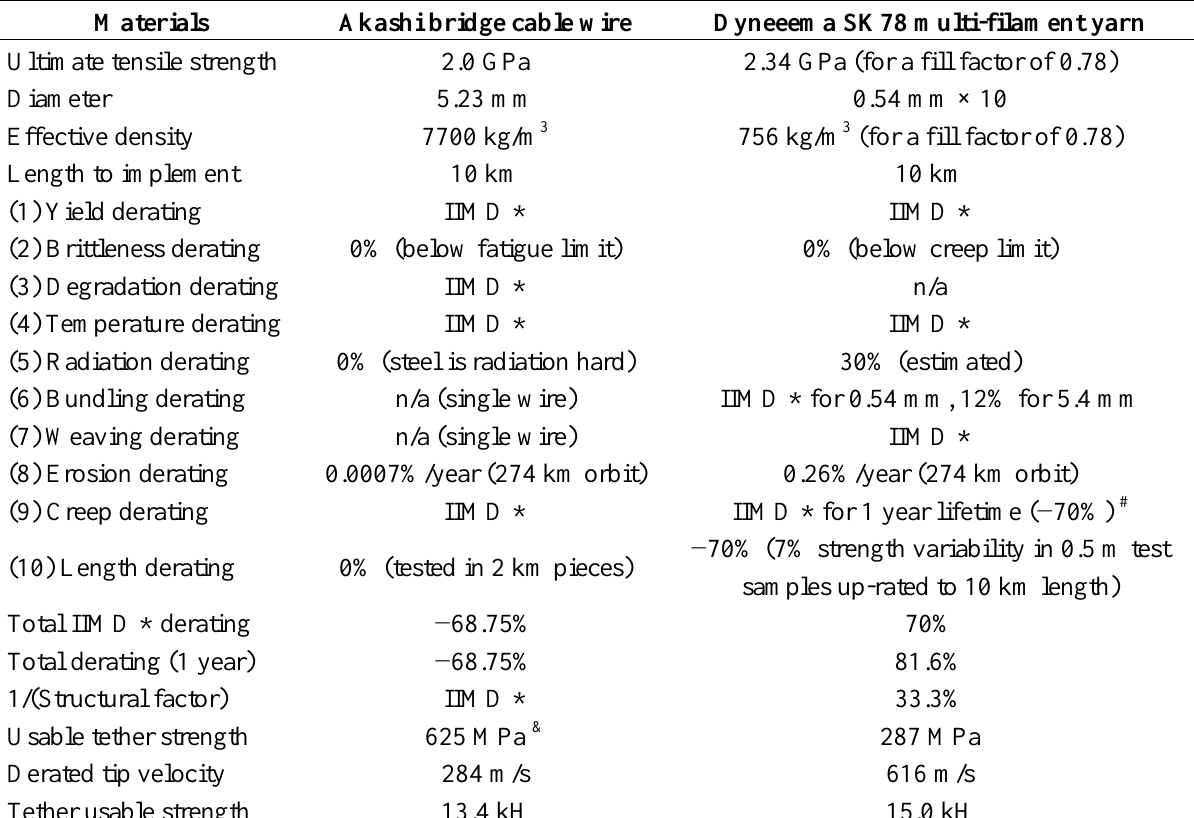
Table 2. The usable strength of the example high-tension